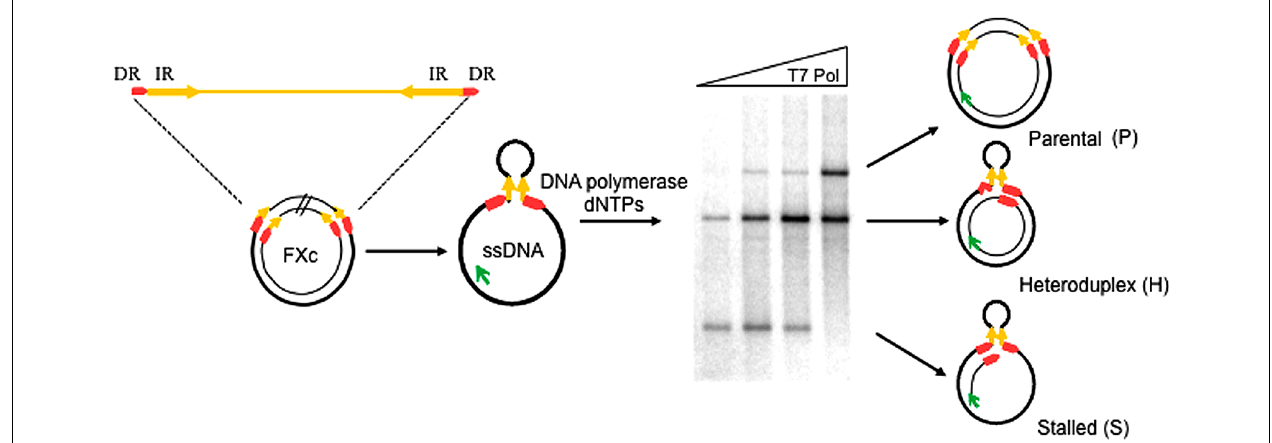
FIGURE 2 | Experimental assay for the detection of replication slippage. Schematic representation of the ssDNA template and the different replication products expected after a primer extension reaction, FXc represents the double-stranded pHP727FXc plasmid containing a central 1370 bp region (insert) flanked by 300-bp inverted repeats (IR: yellow arrows) and 27-bp direct repeats (DR; red arrows). ssDNA FXc template is prepared in vitro and primer extension reactions performed at 60 ◦ C in the presence of a fluorescein-labeled primer (green arrow) and DNA polymerase as described in the “Materials and Methods.” Reaction products are then separated by